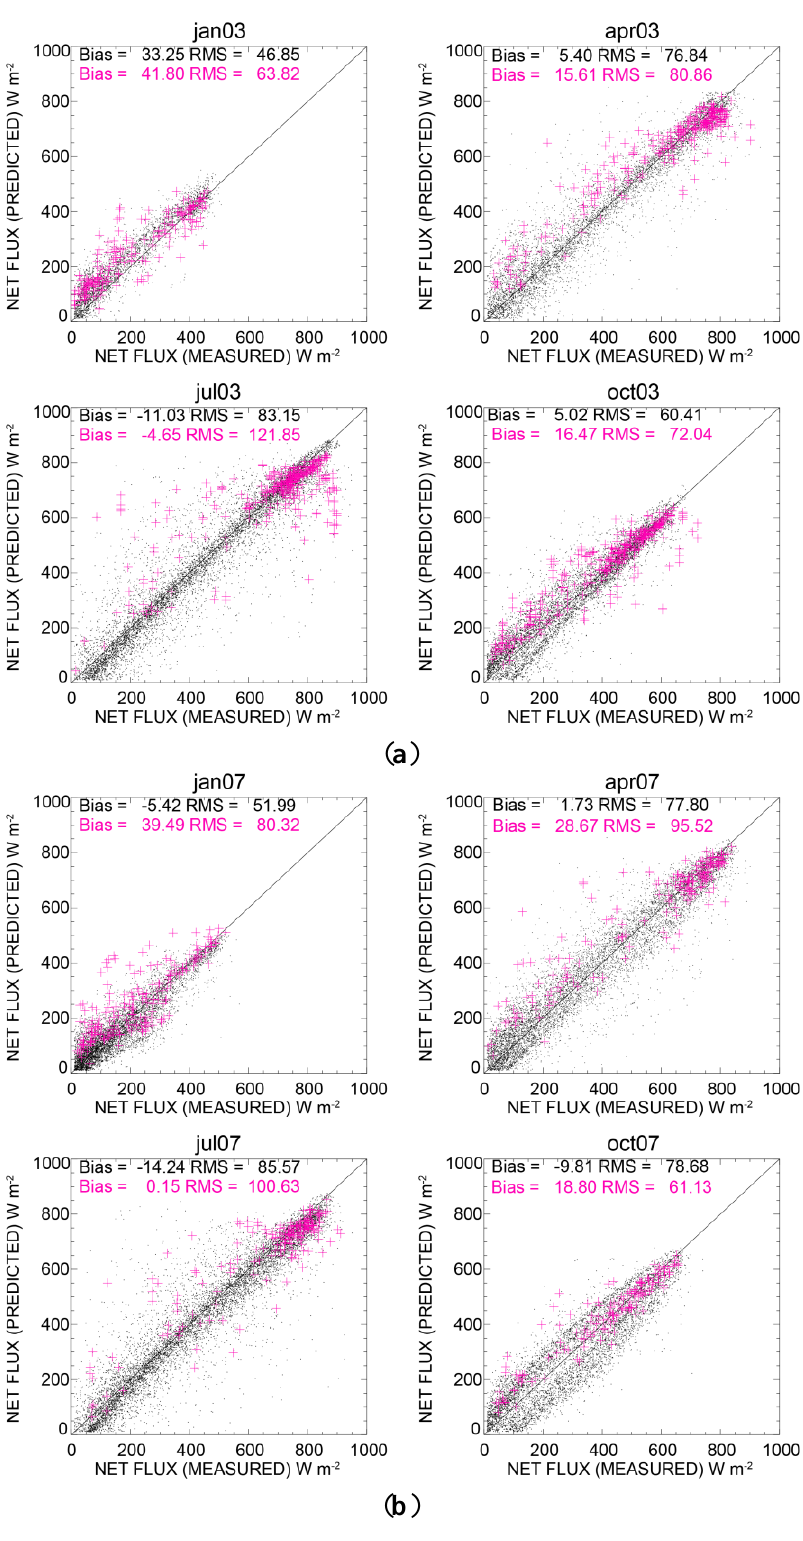
Figure 4. ( a ) Scatter plots of observed versus GOES-derived net surface SW flux for all eight SURFRAD stations combined, for the months of January, April, July and October 2003. The black dots refer to the GOES and the magenta symbols represent the CERES Model B. The corresponding bias and RMS numbers inset in the figure are in W·m −2 ; ( b ) Same as in Figure 4a, but for the months of January, April, July and October